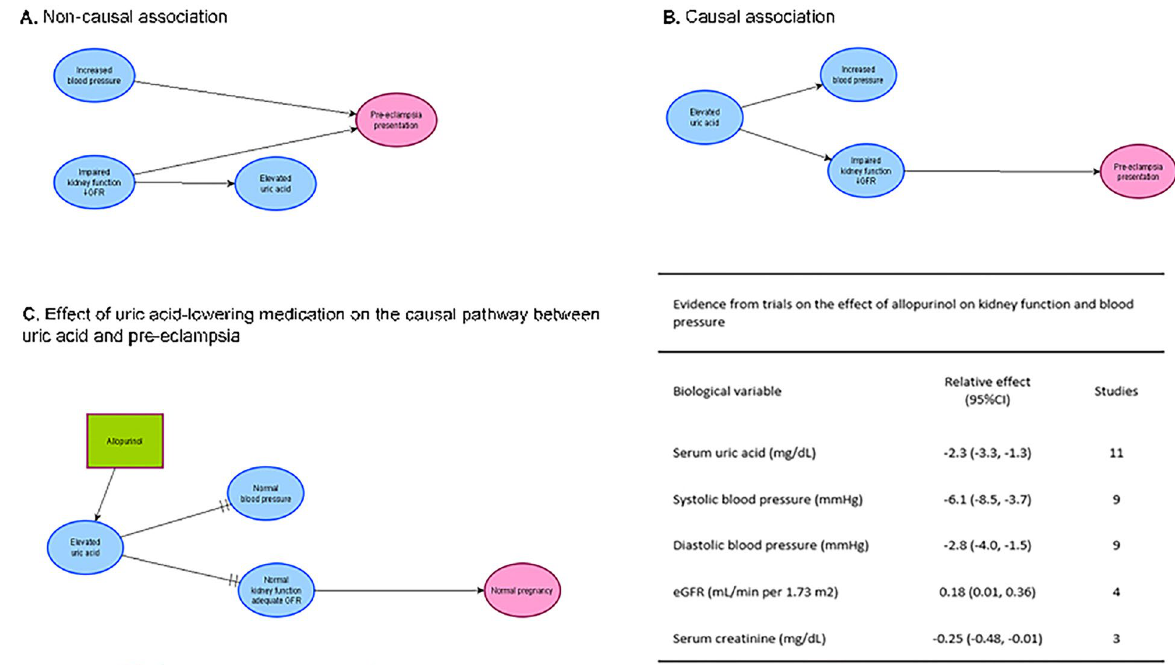
Figure 4. Proposed scenarios for the role of uric acid in pre-eclampsia aetiology. In ( A ), increased uric acid is associated with pre-eclampsia but does not contribute to the pathogenesis of the disease, while in ( B ) uric acid acts as a causal factor for pre-eclampsia. In ( C ), the effect of the uric acid-lowering drug allopurinol 36,37,45,4635,36,44,45 interrupts the causal pathway (as evidenced in non-pregnant